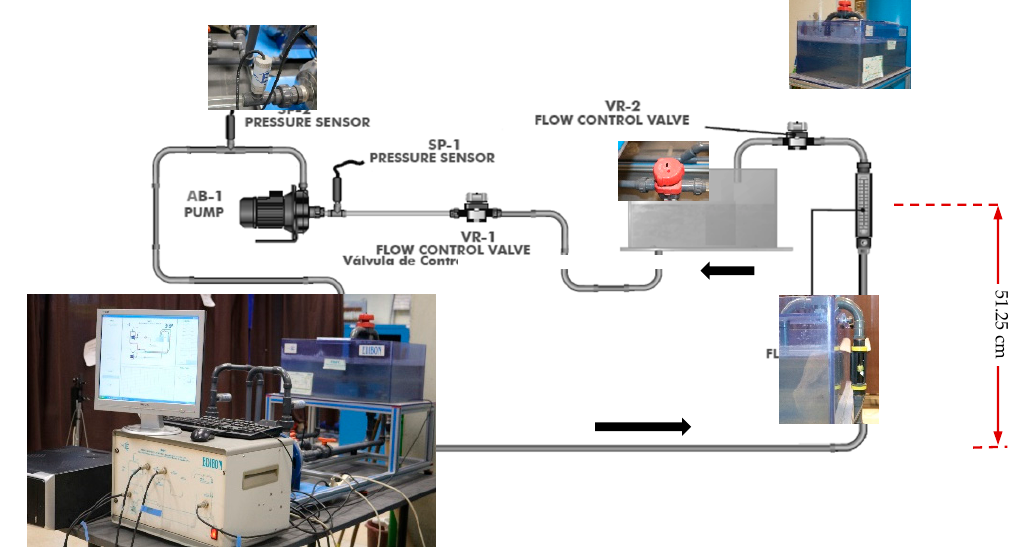
Figure 6. Experimental facility at Instituto Superior Técnico (IST) lab.